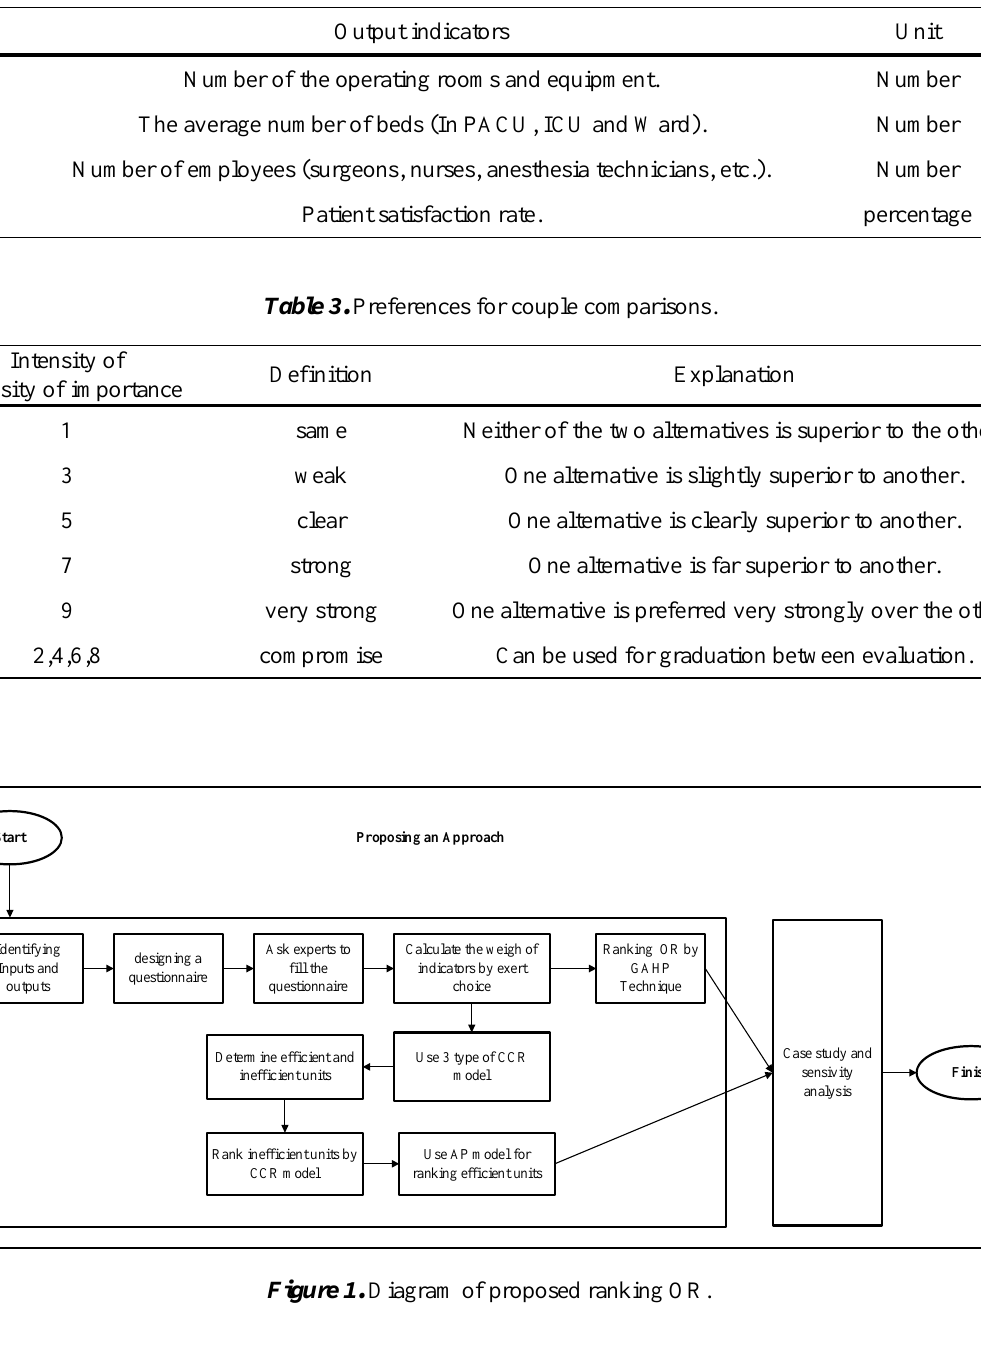
Table 2. Output indicators.